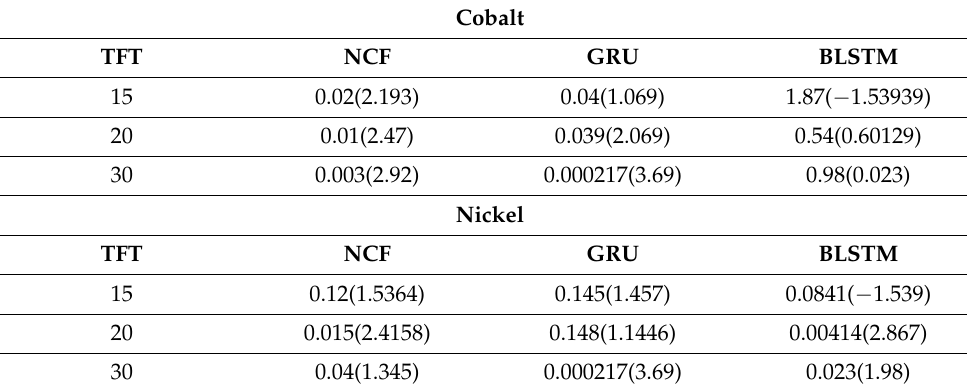
Table 4. The levels of statistical significance as shown by Diebold–Mariano Test, indicating a 5% level of significance, based on the p -value and DM statistics (inside the brackets).